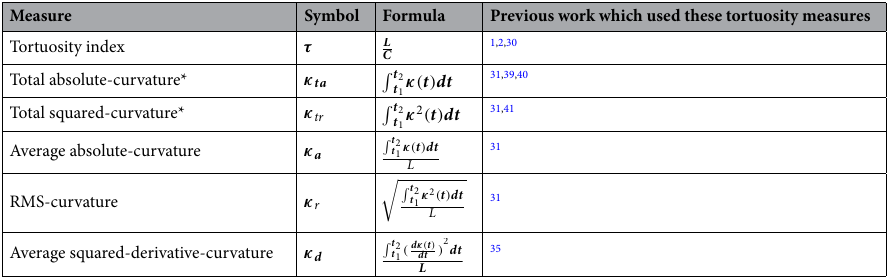
Table 1. Overview of tortuosity measures. L = length of vessel, C = length of chord between vessel ends, κ = curvature. *The total absolute-curvature and the total squared curvature are not considered in this study, since these metrics are not scale invariant and dependent on the arc length of the vessels.